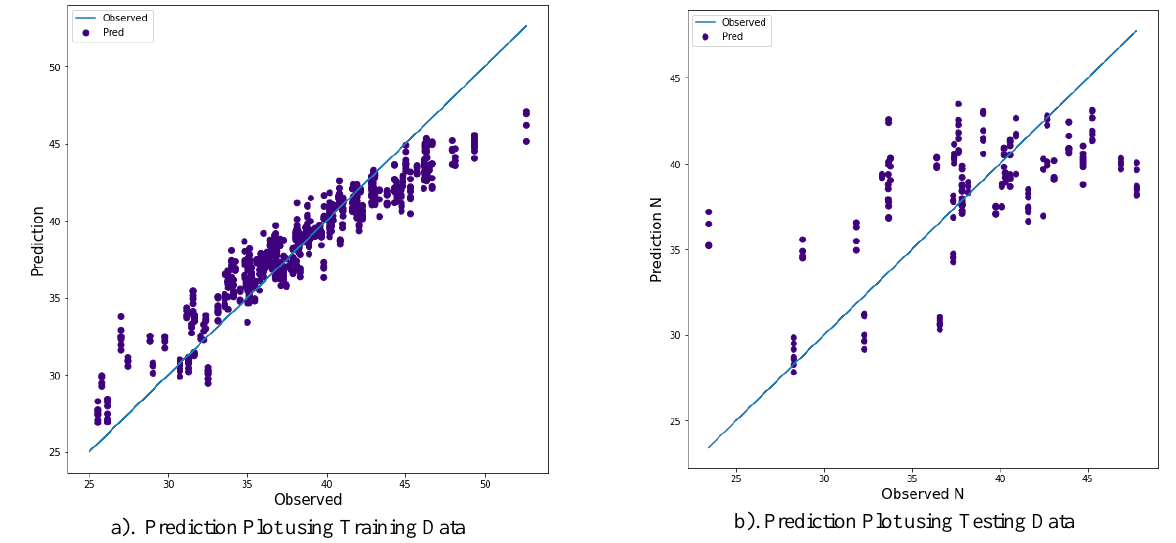
Figure 5 . Prediction Plot a). using Training Data, b). using Testing